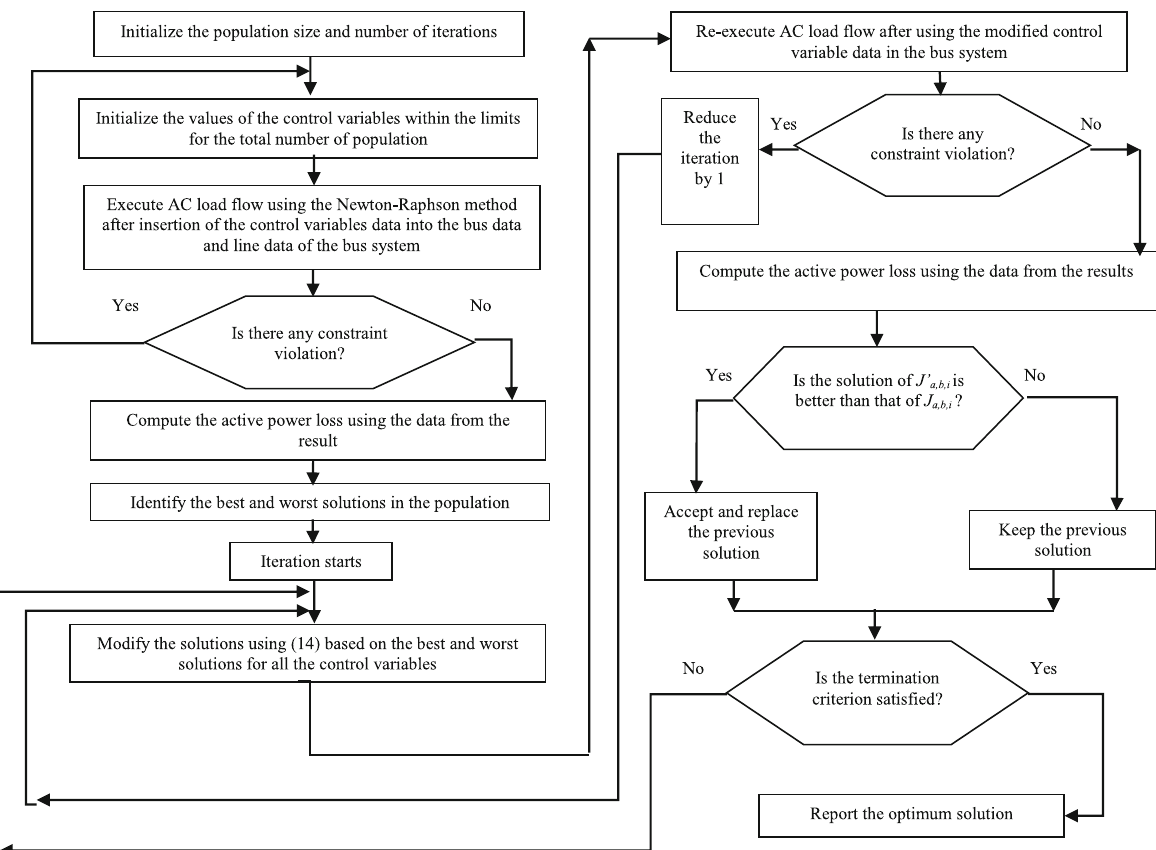
Fig. 1 Flow chart of the JAYA algorithm implemented on the ORPD